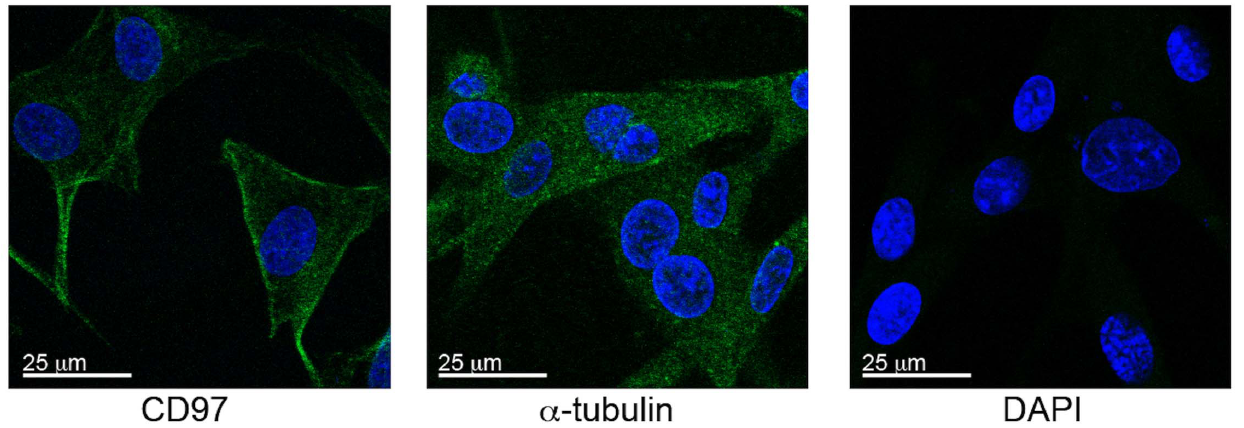
Figure 2. CD97 is localized to the cell membrane. To determine the distribution of CD97 within the cell we performed immunostaining on U87MG cells grown in culture. Compared to a -tubulin, a cytoskeletal marker distributed throughout the cytosolic compartment, CD97 expression was mostly localized to the cell membrane.